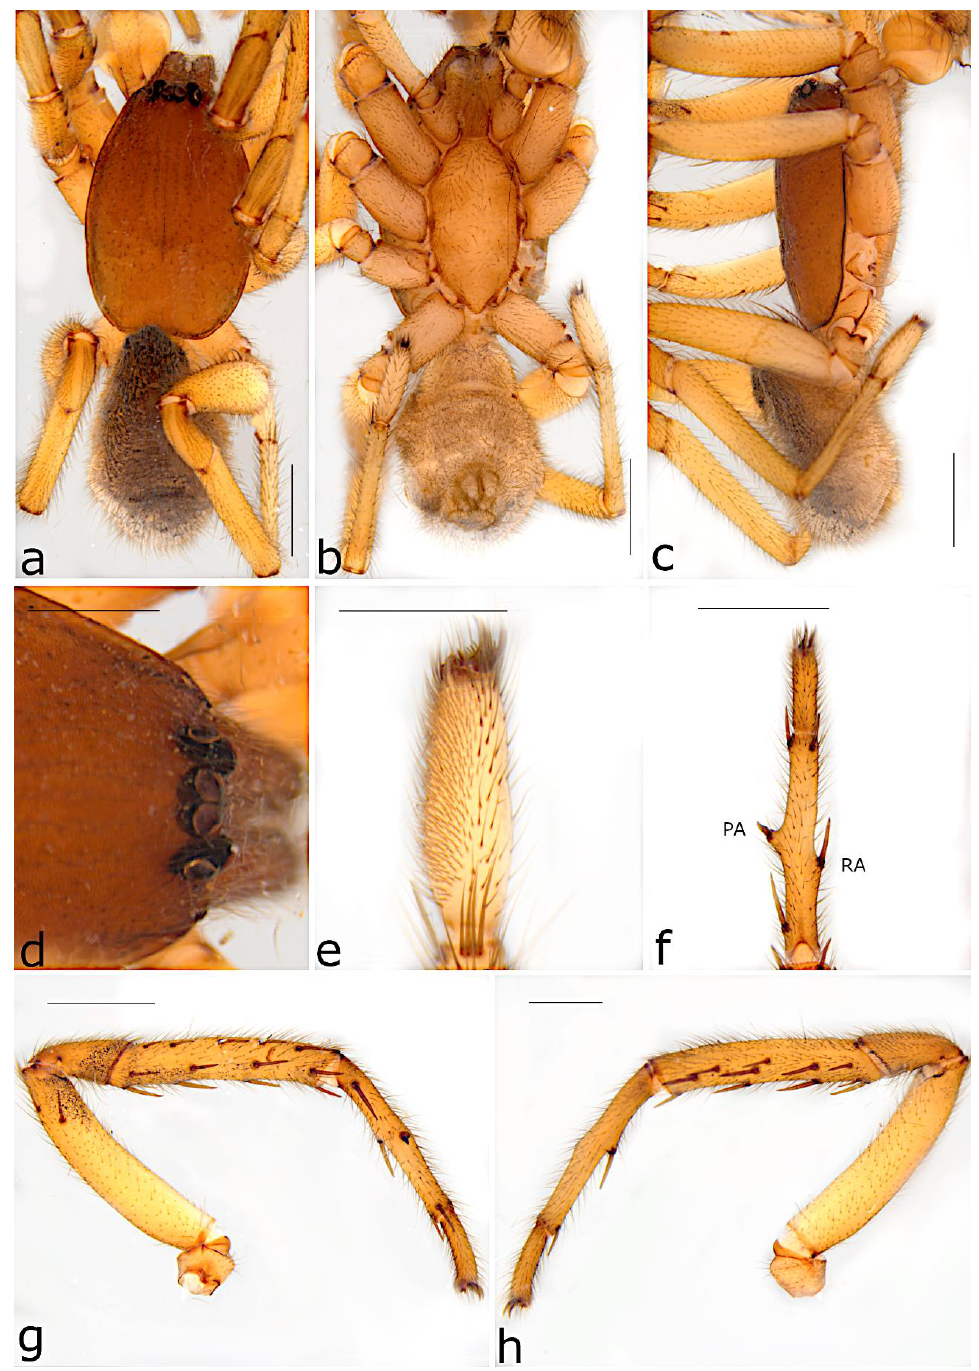
Figure 29. Ariadna bellatula sp. nov. holotype (SAMA NN10577) from Mundy Dam (SA): ( a ) habitus, ♂ dorsal view; ( b ) same, ventral view; ( c ) same, lateral view; ( d ) eyes, dorsal view; ( e ) left metatarsus IV, preening comb, retrolateral view; ( f ) left leg I, ventral view; ( g ) same, prolateral view; ( h ) same, retrolateral view. Scale bars ( a – c ) = 1 mm, d, ( e ) = 0.5 mm and ( f – h ) = 1